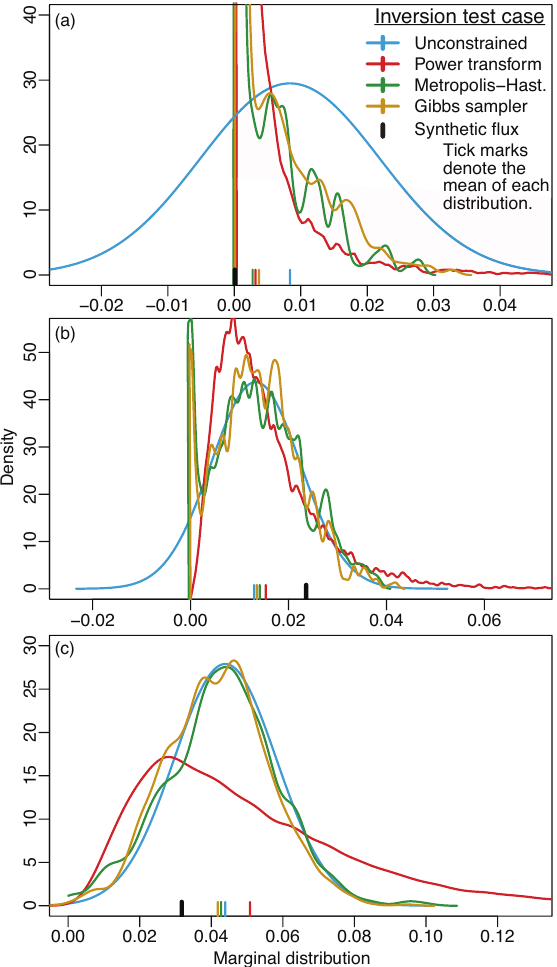
Fig. 4. The marginal posterior density for the estimate of methane emissions at three individual locations. Case (a) is an estimate of emissions north of Thunder Bay, Ontario, Canada; case (b) is over Indianapolis, Indiana; and case (c) is over eastern Kentucky. The unconstrained case is plotted as a normal distribution, and the other plotted probability densities are produced by applying a kernel smoother to the histogram of realizations. Note that this figure does not include the Lagrange multipliers case because this deter- ministic approach produces only a best estimate with no associated marginal densities.